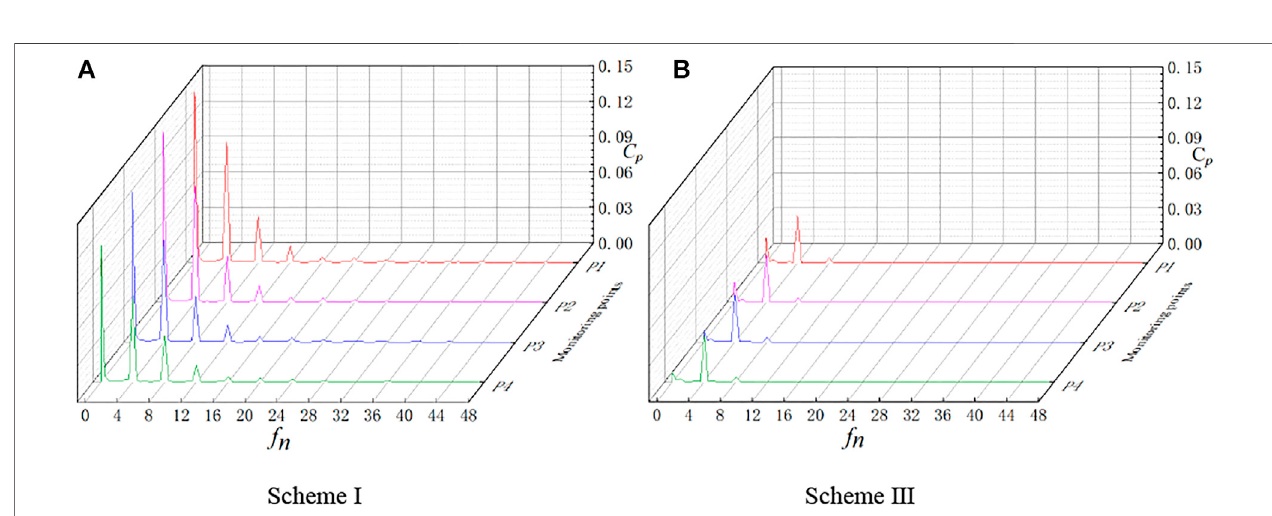
FIGURE 13 | Frequency domain diagram of impeller inlet pressure pulsation( Q / Q d = 0.40). (A) scheme I, (B) scheme III.